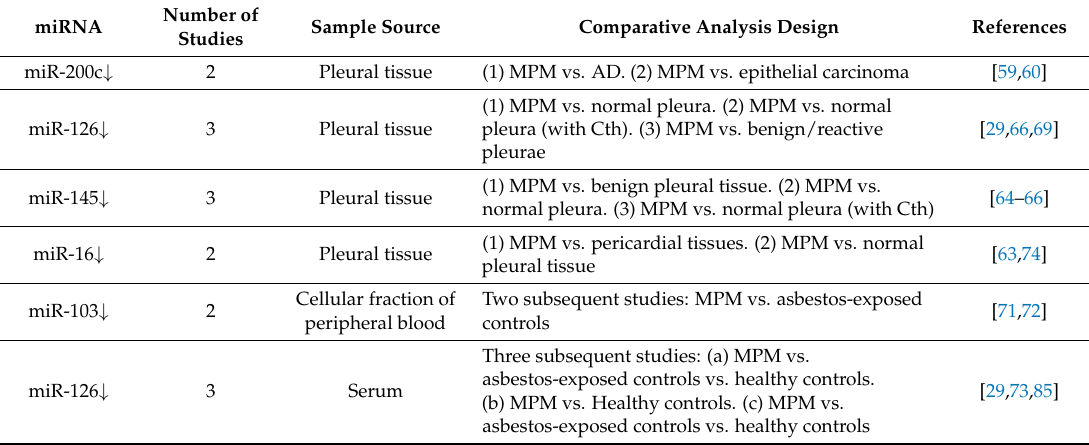
Table 2. miRNAs with potential diagnosis value for MPM reported by at least 2 independent studies. Number of miRNA Sample Source Comparative Analysis Design Studies